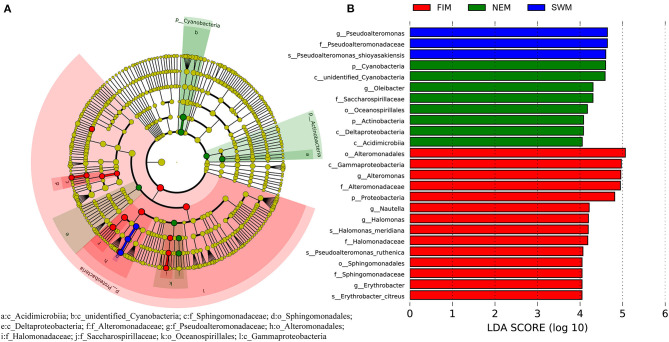
Cladogram based on LEfSe analysis showing the differentially abundant bacteria among samples during the Southwest monsoon (SWM), the fall inter-monsoon (FIM), and the Northeast monsoon (NEM), respectively (A), with a linear discriminant analysis (LDA) threshold of 4 (B). The bacteria with significantly different abundance at different taxonomic levels among samples were highlighted by colored circles and shadings.